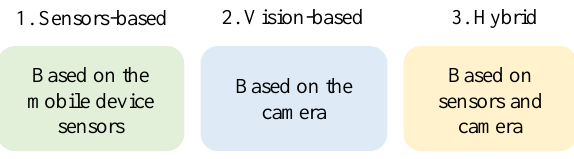
Figure 3. MAR implementation